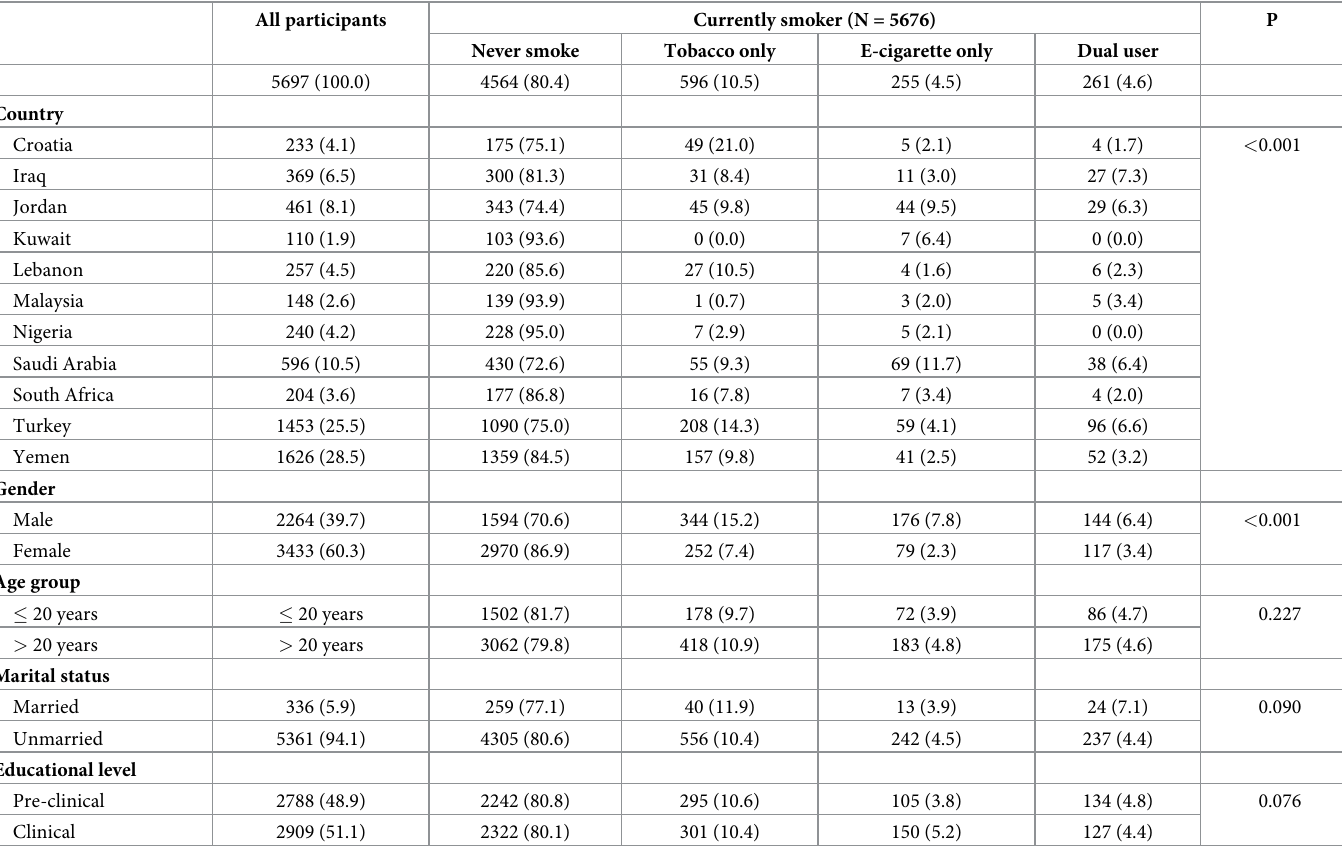
Table 1. Current status on usage patterns of E-cigarettes or tobacco cigarettes by